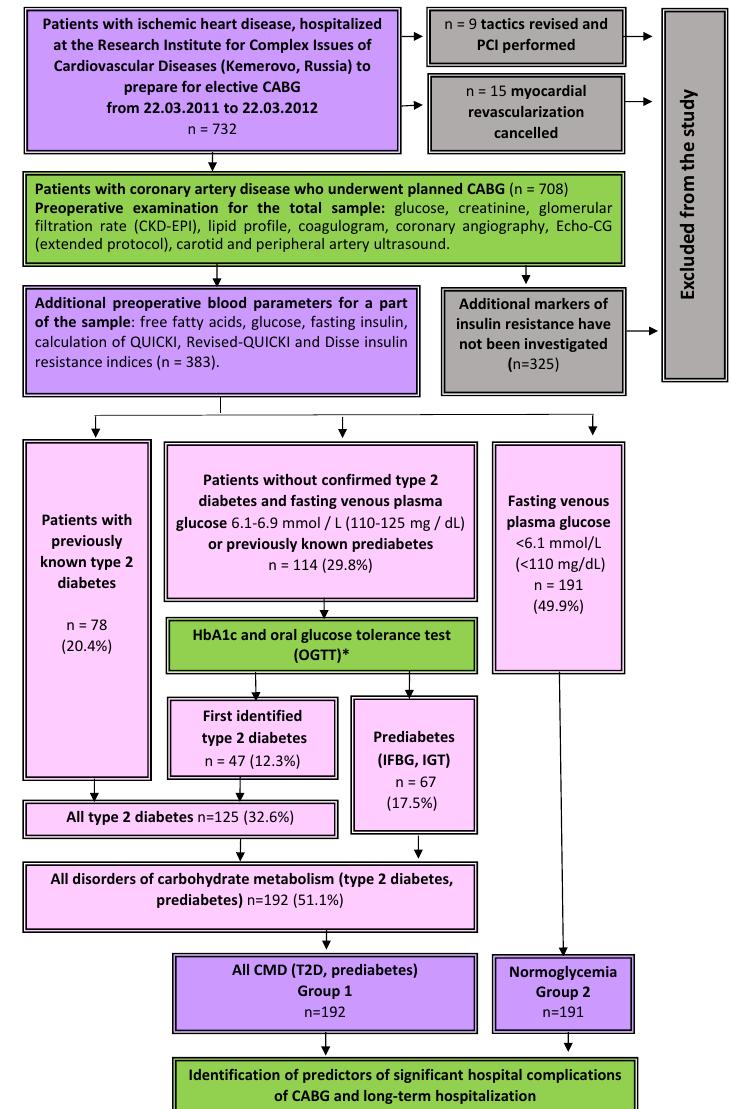
Figure 1. Study design. Notes: PCI—percutaneous coronary intervention, CABG—coronary artery bypass grafting, IFBG—impaired fasting blood glucose, IGT—impaired glucose tolerance, CMD— carbohydrate metabolism